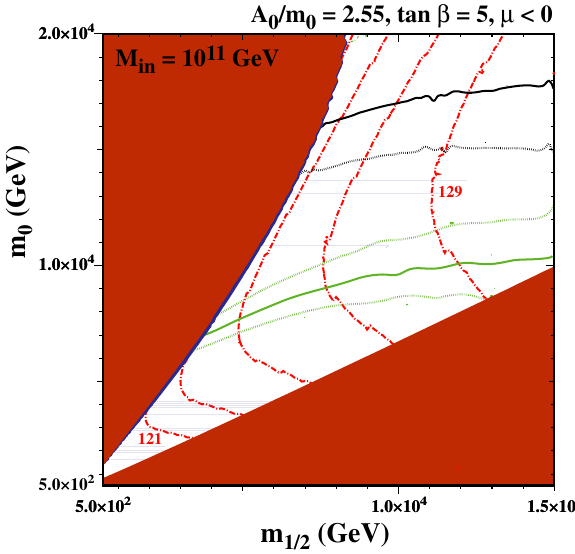
Fig. 15 The ( m 1 / 2 , m 0 ) plane in the sub-GUT model with M in = 10 11 GeV for tan β = 5, A 0 / m 0 = 2 . 55 and μ < 0